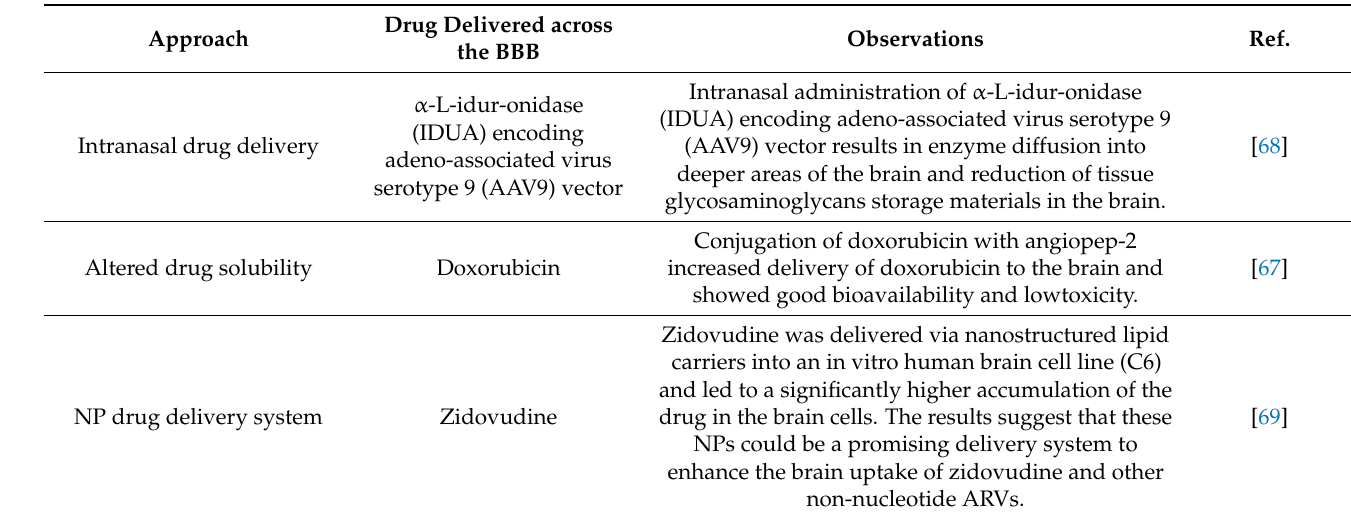
Figure 2. Illustration of transport pathways for BBB transport. ( A ) The transcellular lipophilic pathway allows the passive diffusion of small, lipophilic molecules across the BBB and into the brain. ( B ) Carrier-mediated transport employs specific proteins to move molecules from the environment into and through the cell. ( C ) Endocytosis of molecules via adsorptive transcytosis nonspecifically and transported through the cell. ( D ) Specific ligands bind receptors and are endocytosed and transported through the cell via receptor-mediated transcytosis. ( E ) Translocation of MENs across the BBB. Once MENs have been administered into the body, an externally applied magnetic field changes the shape of the inner core. Magnetostriction, changes the shape of the piezoelectric shell. The magnetic field induces the nanoelectroporation of the diseased cell (see Section 2.3). Table 1. Non-invasive approaches for the delivery of drugs across the